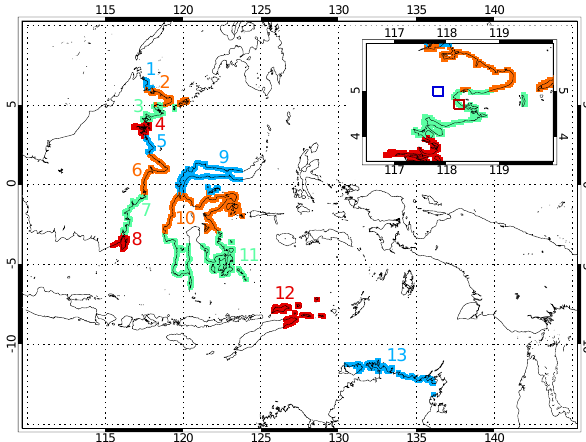
Fig. 4. Air mass history for Kunak. 30000 particles, sharing 10.8kg, were released from Kunak between 17:00 and 20:00MST (UTC+8) on the 23 June 2008. They travelled backward in time for 10 days, with the position of particles in the lowest 100m of the model atmosphere recorded every 15 minutes. At the end of the run, the particle mass below 100m is integrated over the 10 day travel time. Warmer colours indicate a greater probability of a par- ticle passing near the surface in a grid box. Inset: the location of the two measurements sites, 53km apart; Danum (blue cross) and Kunak (red).